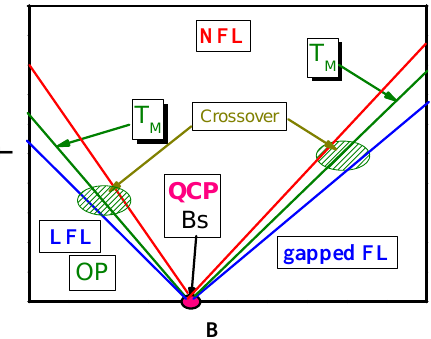
Figure 15. Schematic magnetic field—temperature phase diagram of 1DQSL. Straight lines on both sides of B s , which is a FCQPT point, indicate, respectively, the lines of LFL boundary (the lowest temperature), the temperatures of maxima (middle line, marked “ T M ” taken from Figure 11a) and the end of crossover region: The highest temperature at which the system enters the NFL regime. The left sector labeled as “LFL” and “OP” (ordered phase) displays the LFL behavior and possible ordered phase of spin liquid. The right sector labeled as “gapped FL” denotes the gapped field-induced ferromagnetic spin